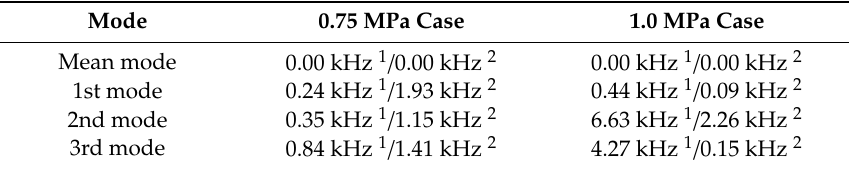
Table 2. Frequencies of all DMD modes according to injection